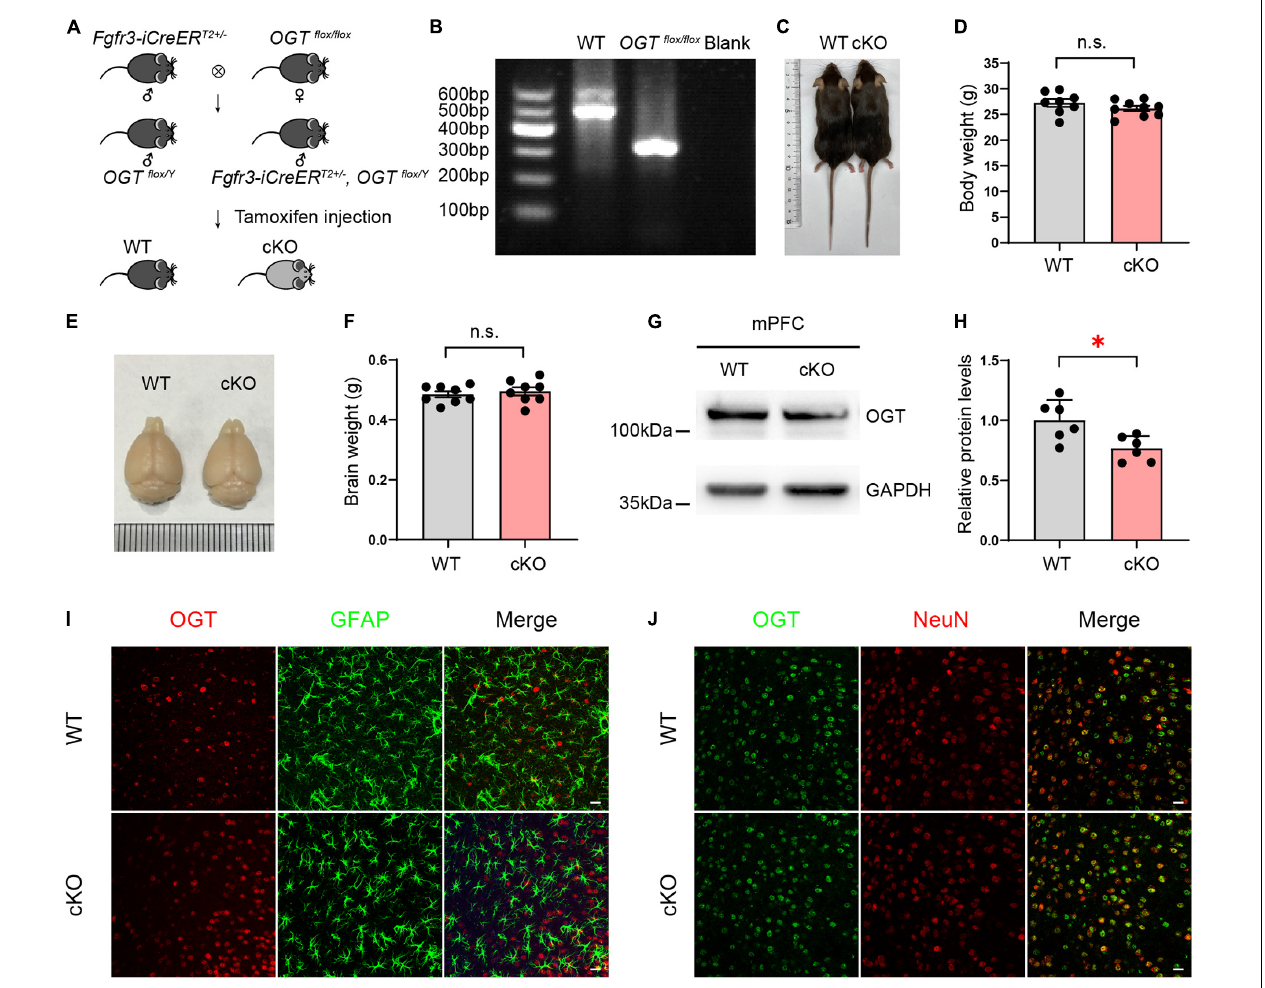
FIGURE 1 | Generation of astrocyte-specific OGT conditional knockout mice. (A) Generation of OGT cKO mice by crossing OGT flox / flox lines with Fgfr3-iCreER T 2 lines. (B) Genotyping of OGT flox / flox mice and littermate wide-type mice. (C,D) The represented image (C) and quantification of body weight changes after TAM injection (D) for cKO and littermate controls. n = 8 (WT), 9 (cKO). (E,F) Representative image (E) and the quantification of brain weight change (F) after TAM injection. n = 8 (WT), 8 (cKO). (G,H) Western blot images (G) and quantification (H) of OGT levels in the mPFC of cKO and WT mice. n = 6 (WT), 6 (cKO). (I) Double immunofluorescence staining of OGT (red) with GFAP (green) in cKO and WT mice. Scale bar = 20 µ m. (J) Double immunofluorescence staining of OGT (green) with NeuN (red) in cKO and WT mice. Scale bar = 20 µ m. All data are presented the mean ± SEM. Two-sided unpaired t -test, ∗ P < 0.05; n.s, no